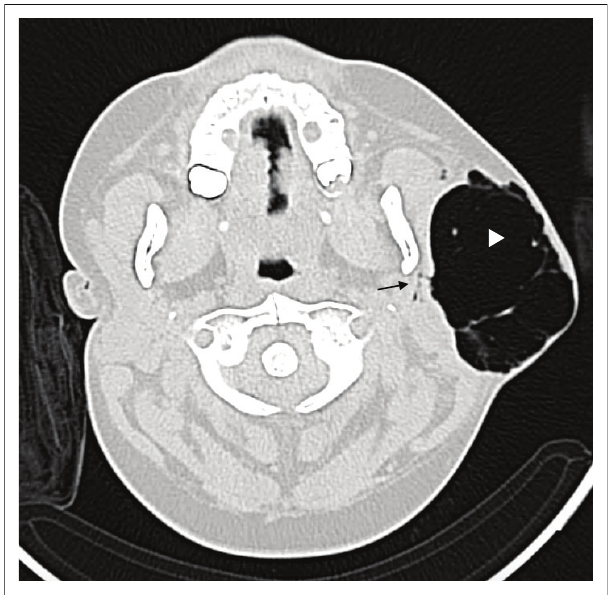
FIGURE 1: Axial non-contrasted computed tomography demonstrates a large, multiseptated focal collection of gas in the subcutaneous tissue overlying the left parotid gland (white arrowhead). Underlying communication with branching gas pattern in the ductal system of the left parotid gland is shown (black arrow). No gas is present in the parapharyngeal fat space or deep neck